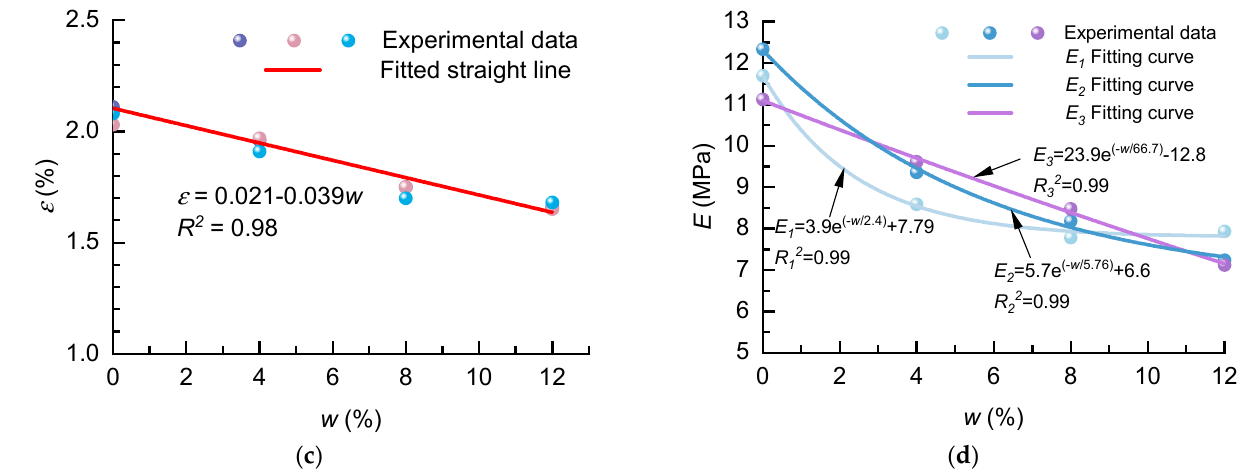
Figure 7. Mechanical properties of single-axis compaction of coal samples at varying water contents. They should be listed as: ( a ) stress–strain, ( b ) uniaxial compressive intensity, ( c ) maximum pressure, and ( d ) modulus of elasticity.